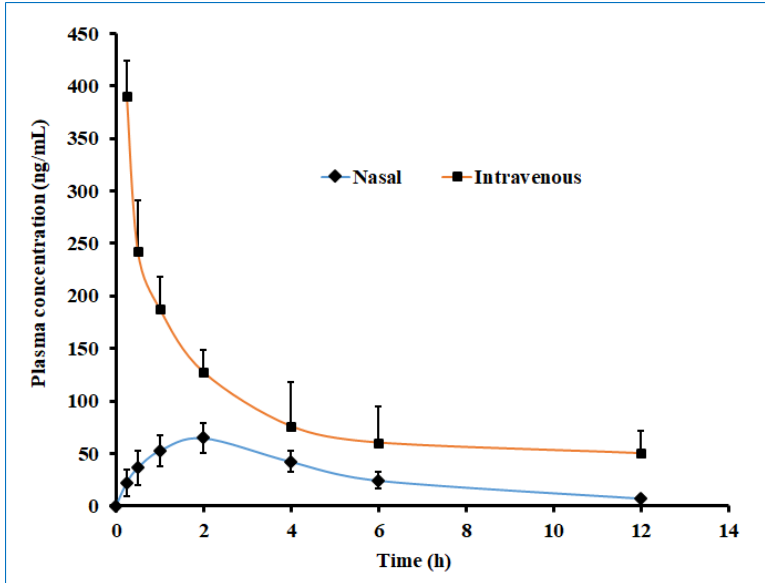
Figure 13. The plasma drug concentration–time profile of darunavir after administration by nasal (optimized in situ gel, 30 µ L, 2.4 mg/kg) and intravenous (solution, 0.4 mL, 2.4 mg/kg) routes in rats. The data presented are the average of six animals at every time